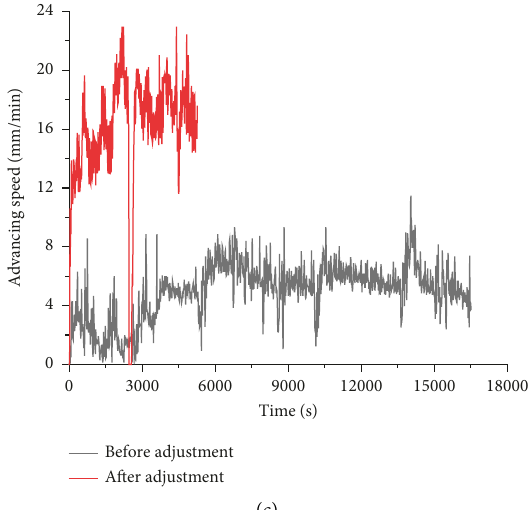
Figure 13: Shield tunnelling parameters before and after cutter height difference adjustment. (a) Thrust force. (b) Cutterhead torque. (c) Advancing